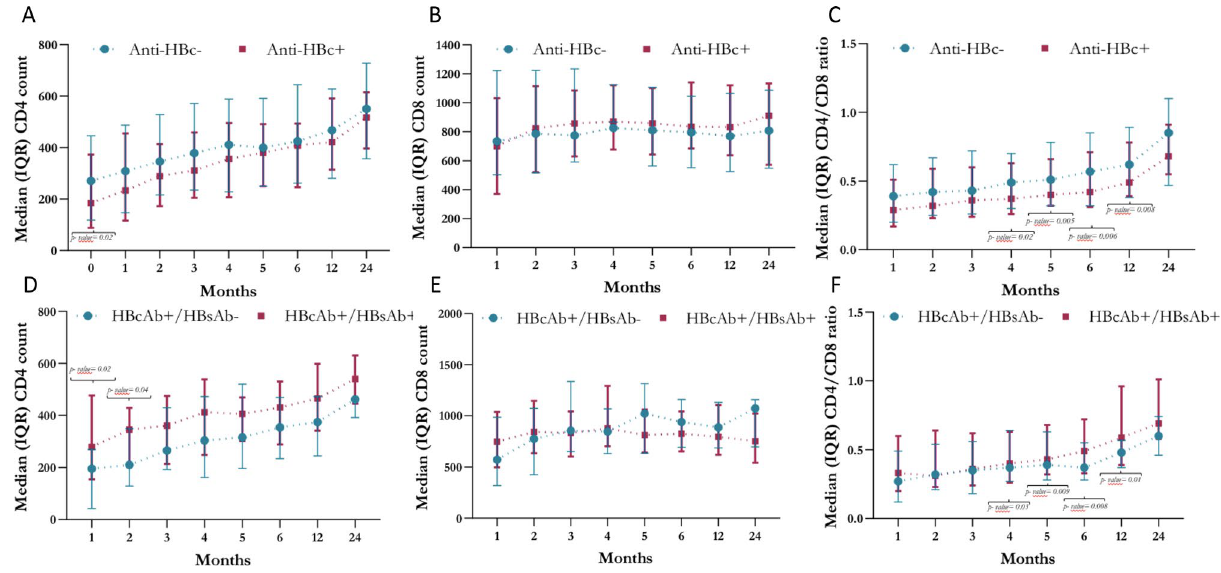
Figure 2. Comparison between CD4+ and CD8+ T cell numbers and CD4/CD8 ratio improvement in the 24 months following the start of cART in a population of HBcAb+ and HBcAb- HIV-positive subjects ( A , B and C , respectively) and of HBcAb+ /HBsAb- and HBcAb+ /HBsAb + HIV-positive subjects ( D , E and F ,